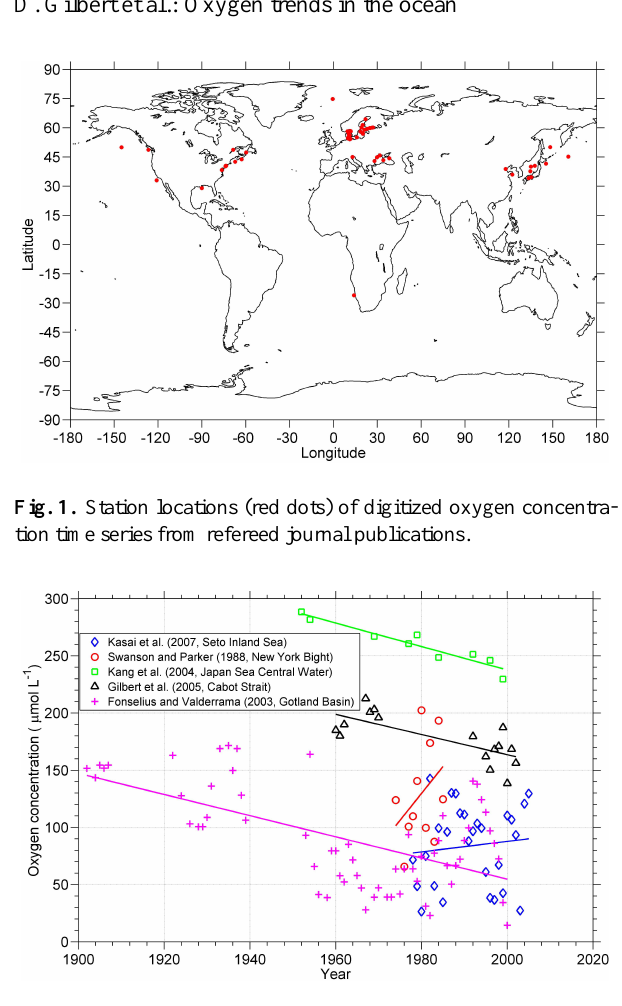
Fig. 2. Examples of digitized oxygen time series from refereed jour- nal papers and our fitted linear trends. The Gotland Basin time se- ries is from 100m depth.